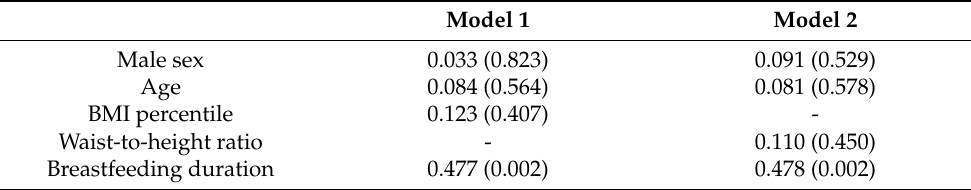
Figure 1. Correlation between duration of breast feeding and spirometric indices (N = 46). Table 3. Dependencies of FEF25-75 % predicted (log) (N = 46) *.